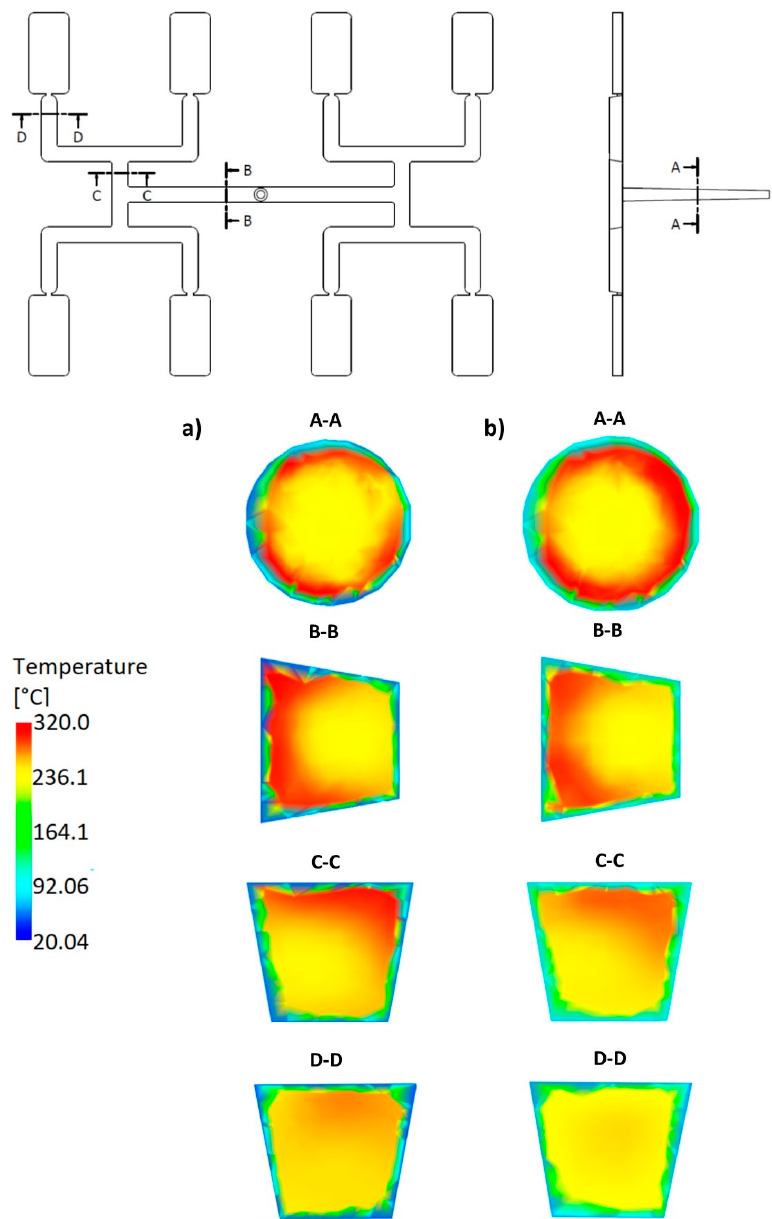
Figure 23. Temperature distribution in the selected cross-sections of the runners for different thermal diffusivity at high injection rate in the case of the standard geometry GS : ( a ) α = 0.005 mm 2 /s ( I m = 22%), and ( b ) α = 5 mm 2 /s ( I m = 12%).